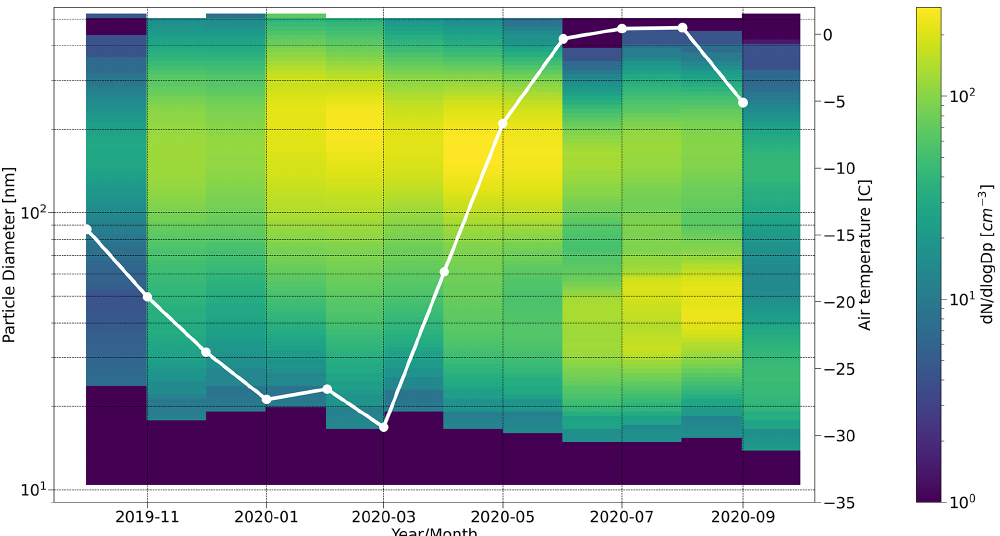
Figure 4. The annual aerosol size distribution and air temperature in the central Arctic during MOSAiC. The size distribution data are pre- sented as monthly medians of the PNSD bins, where the concentration of the bins is represented by the color bar in d N/ dlog D p . The surface air temperature (in white), depicted as monthly averages, is included to give context to seasonal changes in the aerosol size